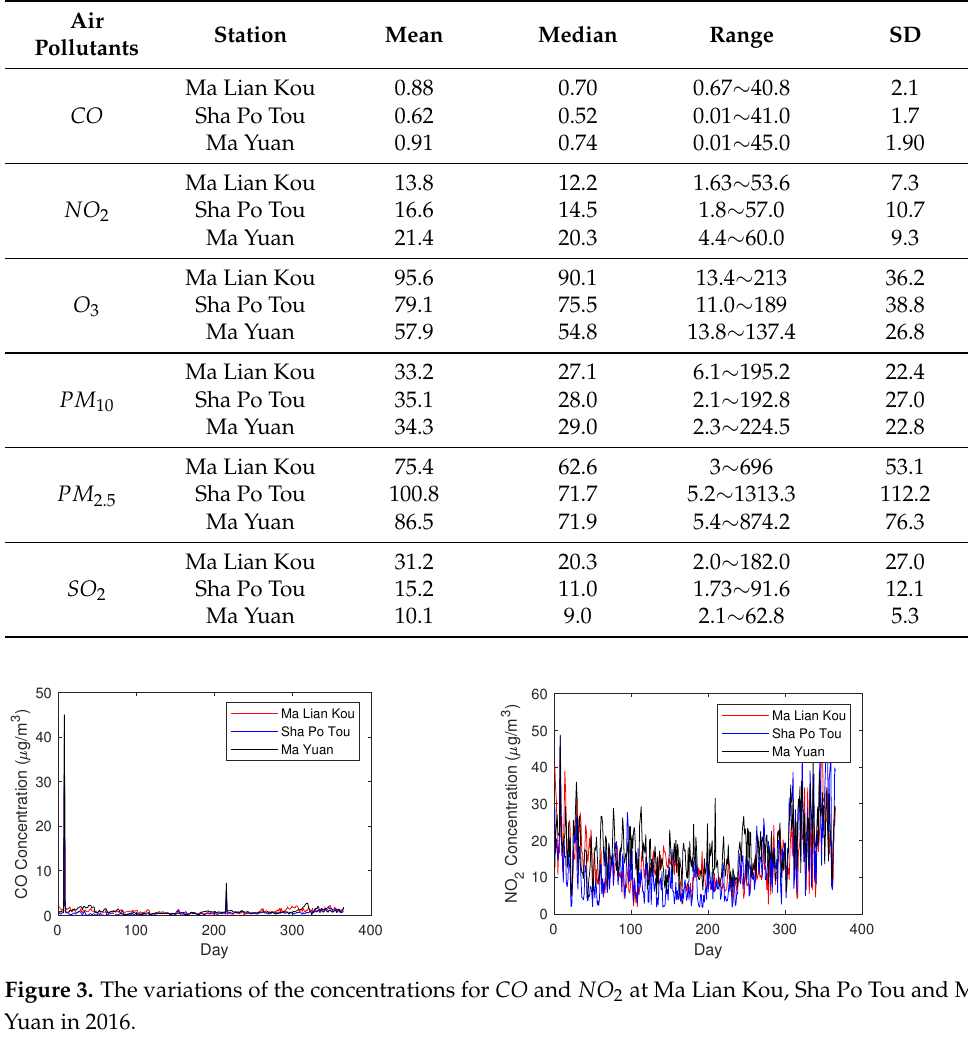
Table 2. Basic descriptive statistics of the observed concentrations. Minimum, maximum, mean and standard deviation of six output parameters during 2016–2017 used in this study, all in µ g/m 3 .